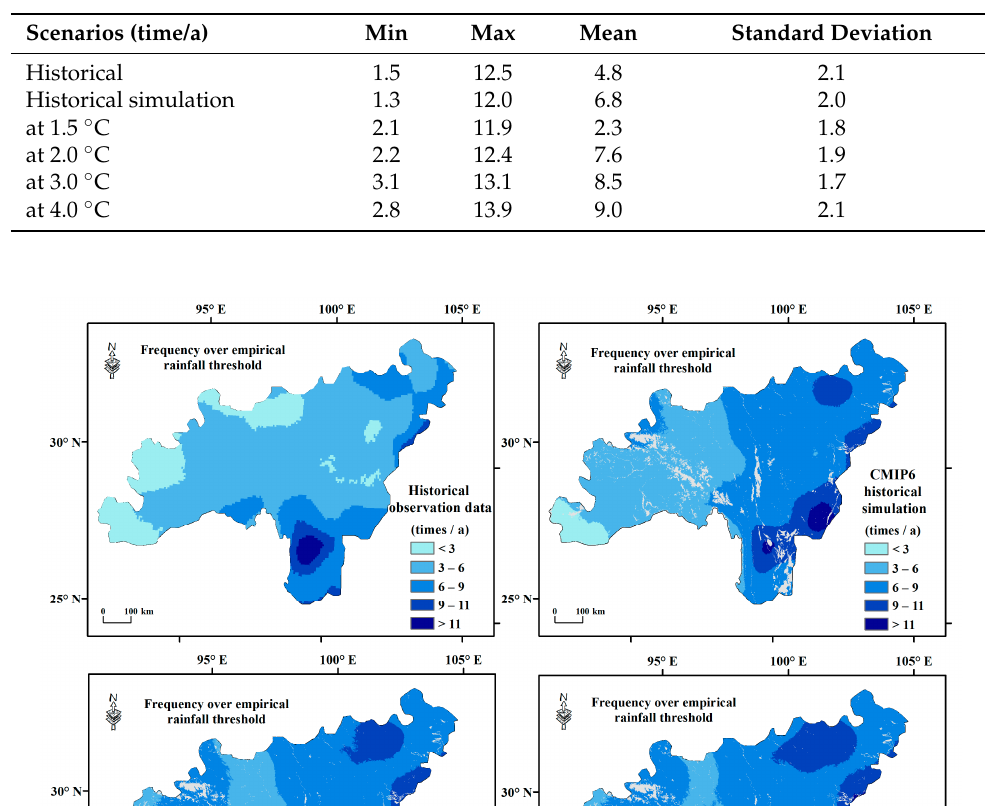
Table 6. Historical FEROT and CMIP6 statistical values regarding simulated rainfall.